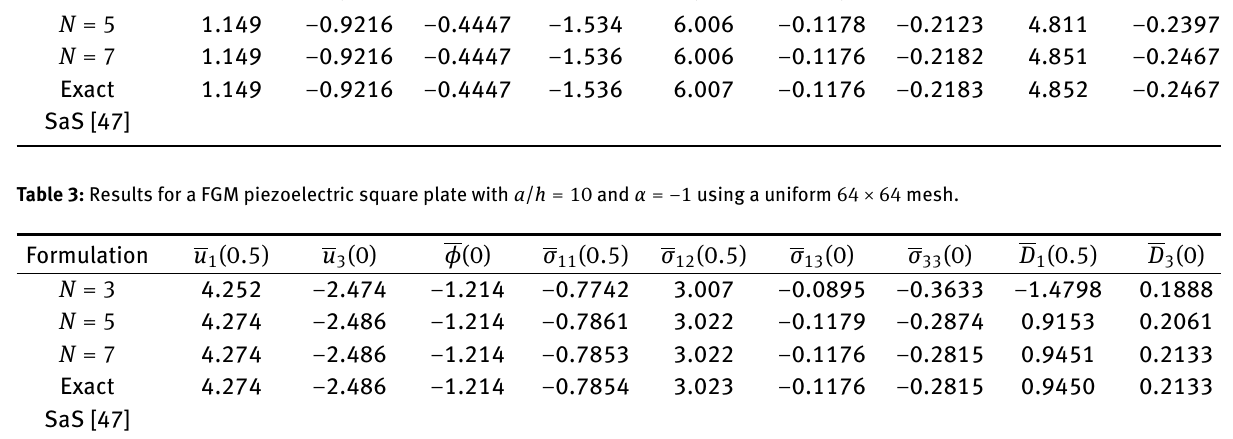
Table 2: Results for a FGM piezoelectric square plate with a / h = 10 and α = 1 using a uniform 64 × 64 mesh. Formulation